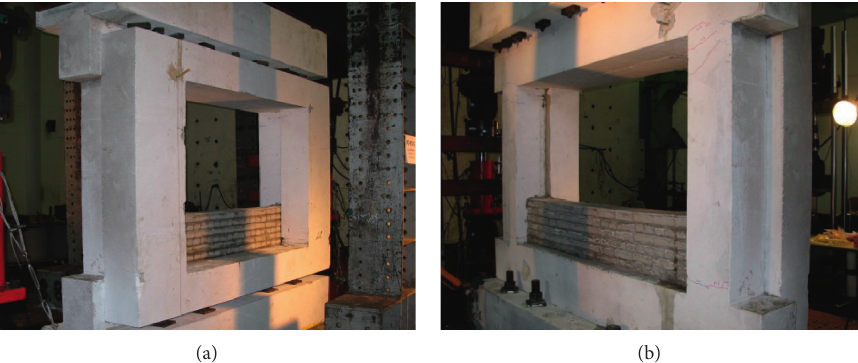
Figure 22: Cracks appeared in the PD-WESRCF specimen during pseudodynamic testing at 300gal after (a) 4.5s with lateral displacement of 7.32mm and force of 320kN, and (b) during the final stage